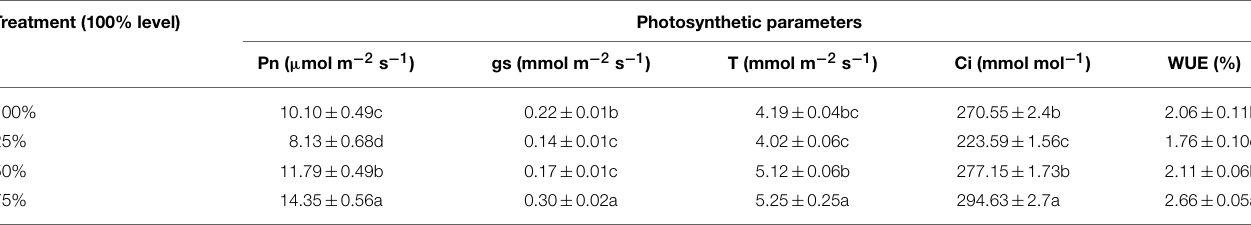
TABLE 1 | Net photosynthetic rate (Pn), stomatal conductance (gs), intercellular CO 2 concentration (Ci), transpiration rate (T), and water use efficiency (WUE) of C. acuminata leaves were subjected to different levels of irradiance. Treatment (100% level)